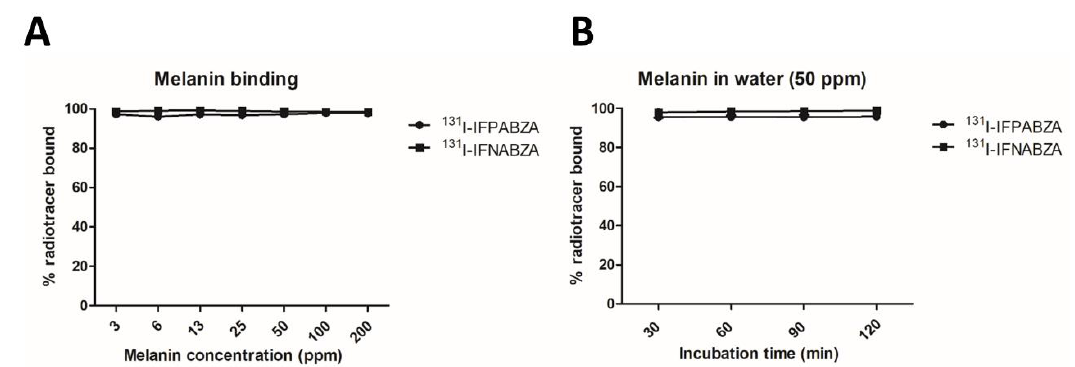
Figure 4. In vitro binding assay between 131 I-IFPABZA / 131 I-IFNABZA and melanin. ( A ) Binding with Figure 4 . In vitro binding assay between 131 I-IFPABZA/ 131 I-IFNABZA and melanin. ( A ) Binding with various concentrations of melanin at 37 ◦ C for 1 h. ( B ) Bound ratio of radiotracers with 50 ppm of various concentrations of melanin at 37 °C for 1 h. ( B ) Bound ratio of radiotracers with 50 ppm of melanin suspension at 37 ◦ C after di ff erent incubation melanin suspension at 37 °C after different incubation time.